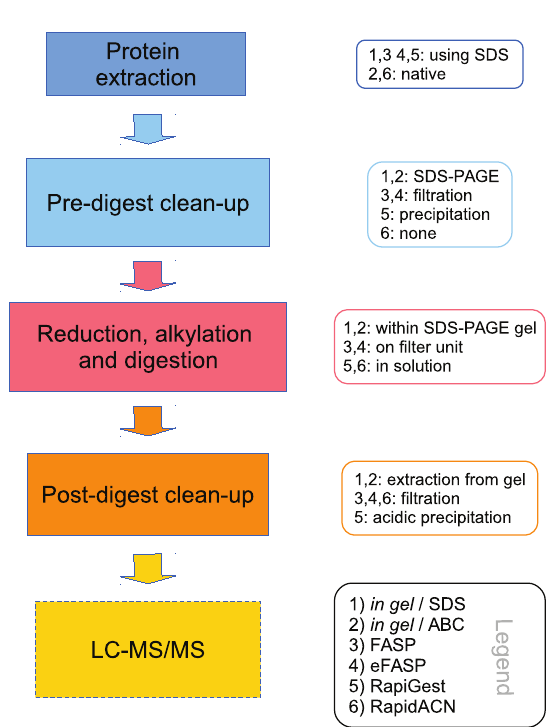
Figure 1. Characteristics of label-free sample preparation methods. Left panel: Schematic overview of the different steps in an LC-MS/MS sample preparation method. Right panel: Main characteristics of the protocols compared in this study. Detailled protocols are given in the Supplementary material. Supplementary protocol 1: In gel/SDS; 2: In gel/ABC; 3: FASP; 4: eFASP; 5: RapiGest; 6: